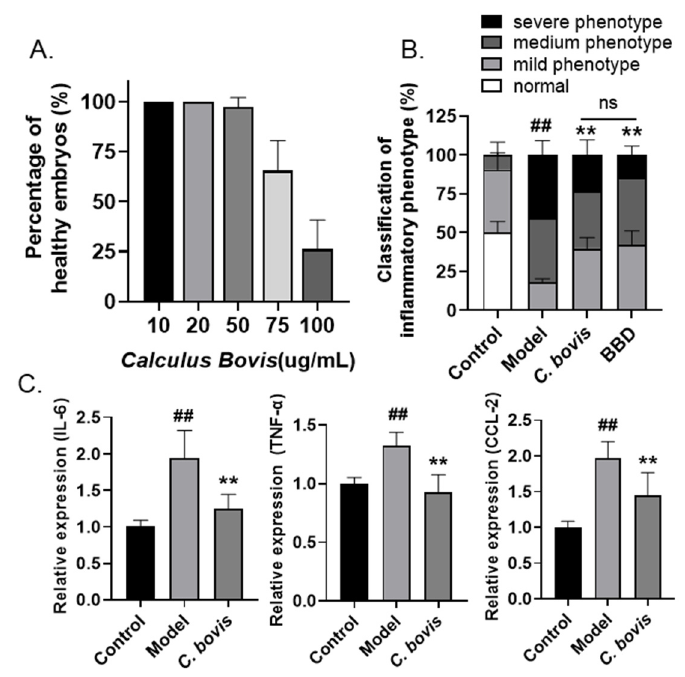
Figure 2. Anti-inflammatory effects of C. bovis on LPS-induced zebrafish inflammation model. ( A ) Toxicity of C. bovis treatment (n = 10). Larvae with cardiac edema, or body distortion, are defined as unhealthy. ( B ) The classification of inflammatory phenotypes in zebrafish embryos of different groups. The combined percentage of the medium and severe phenotypes was statistically analyzed among different groups (n > 10). Control: PBS injection; model: LPS injection. ( C ) The mRNA levels of IL-6, TNF- α , and CCL-2 in zebrafish embryos of different groups (n > 10). All the data are presented as the mean ± SEM of three independent experiments. # Compared with the control group; * compared with the model group; ## or **, p < 0.01.